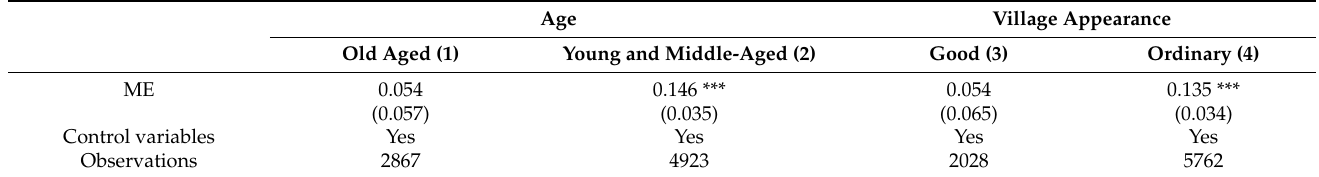
Table 8. Heterogeneous Effects: age and village